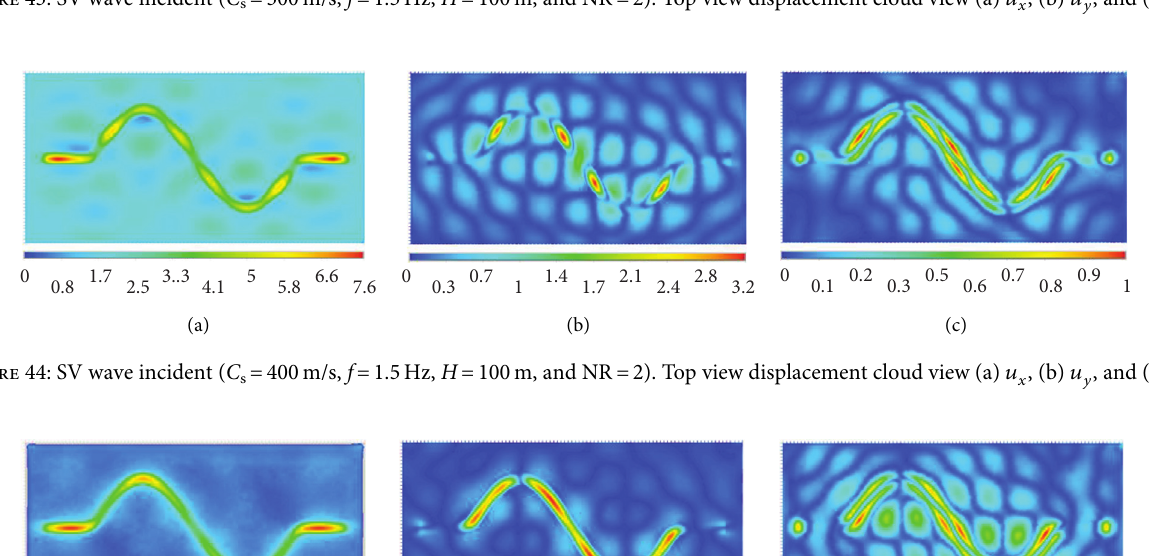
u u x , (b) y , and (c) z .